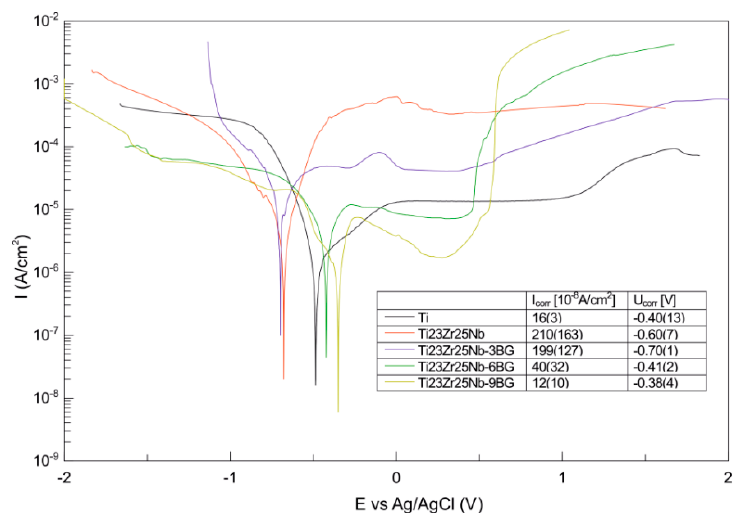
Figure 11. Potentiodynamic curves of bulk Ti23Zr25Nb-based composites with the 3, 6, and 9 wt.% 45S5 Bioglass content in contrast to cp-Ti and the Ti23Zr25Nb alloy.